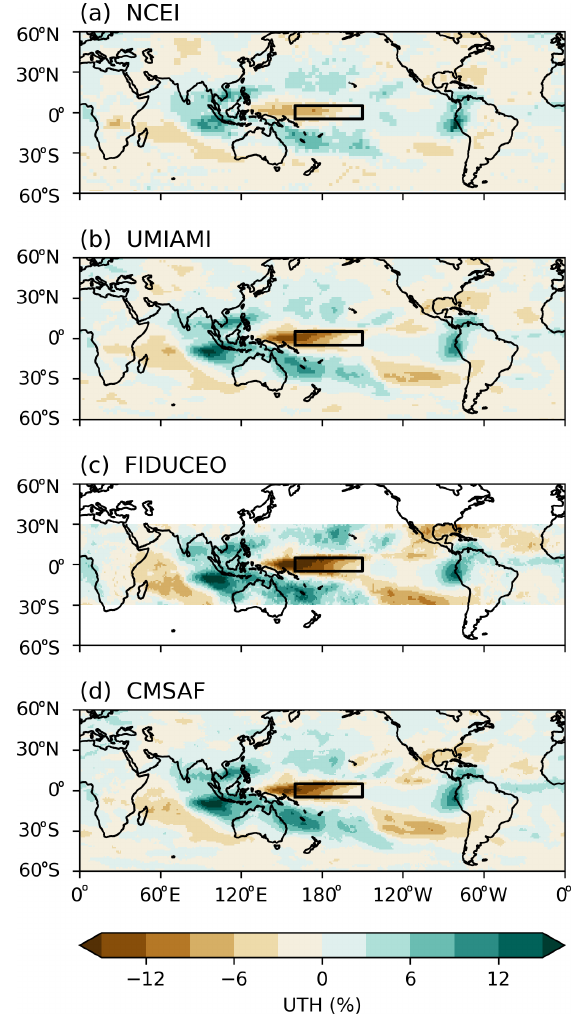
Figure 10. Anomalies of UTH during the peak 6 months of the 2010–2011 La Niña event. The box shows the Niño 4 domain in the central Pacific (5 ◦ S–5 ◦ N, 160 ◦ E–150 ◦ W).